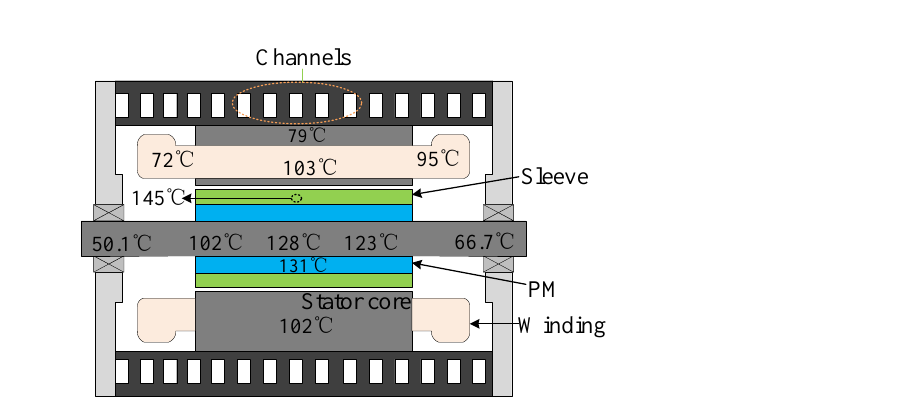
Figure 15. Example of temperature distribution of 100 kW 100 kr/min high-speed PM motor.